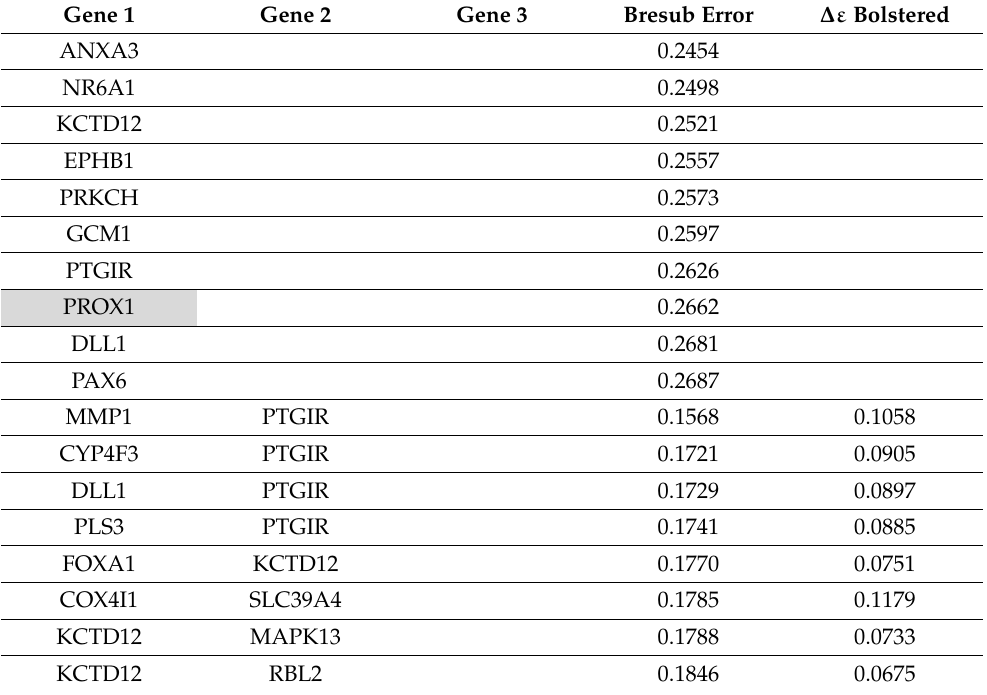
Table 2. Top ten one-, two- and three-gene linear discriminant analysis classifiers in high-ENL excreters are shown. Highlighted genes were also differentially expressed after flaxseed lignan extract vs. placebo treatment in high-ENL excreters. “bresub error” indicates the bolstered resubstitution error for the respective classifier (classifiers are ranked according to that error measurement); “ ∆ ε bolstered” represents the decrease in error for each gene set relative to its highest ranked subset of